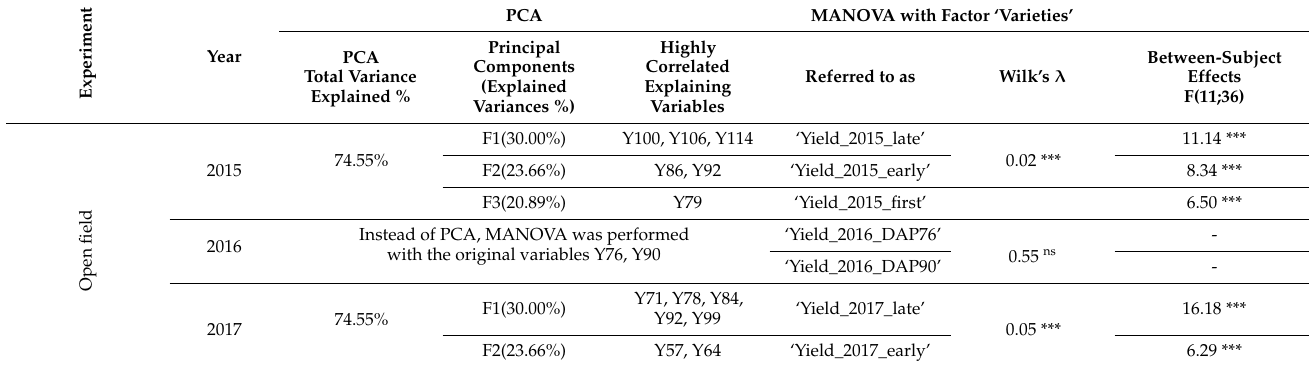
Table 6. The results of the principal component analysis for the yield of the open-field experiment: the explained variances of the PCs as well as the total explained variance rates; the original variables that are highly correlated with the PCs (with high loadings) and the names that refer to the PCs later on; Wilk’s λ (unexplained variance rate) values (overall MANOVA results) and the follow-up ANOVA tests (between-subject effects) with F values and their significances.